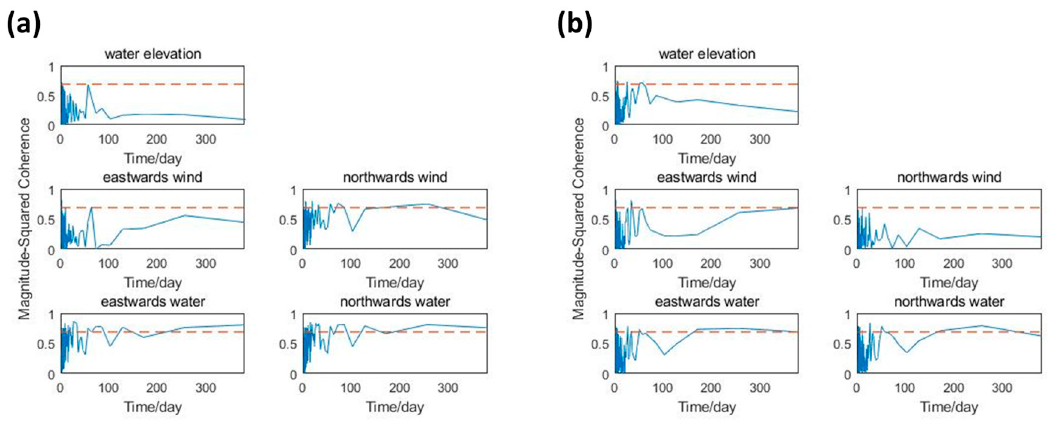
Figure 6. Magnitude-squared coherence of solute concentration with different forcing variables. ( a ) The Kalmar coast case. ( b ) The Vistula coast case. Red dashed line shows coherence at a 95% significance level.